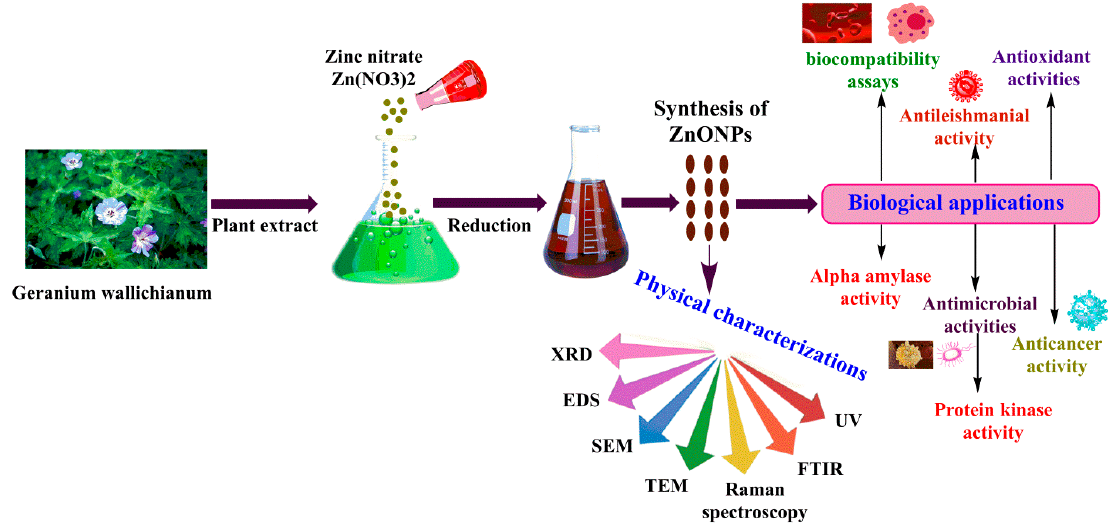
Figure 1. The process of green synthesis of leaf extract-conjugated zinc oxide nanoparticles.